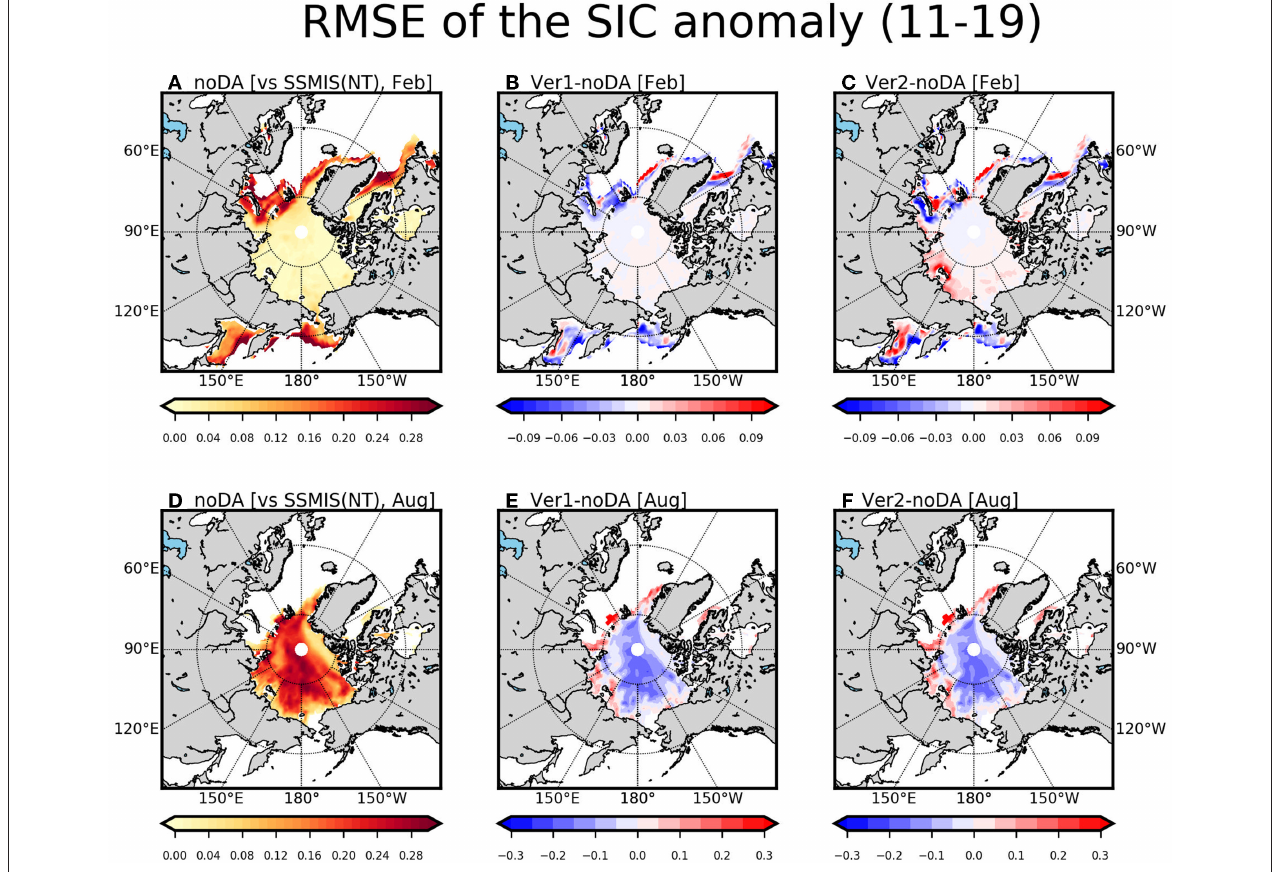
FIGURE 11 | The root-mean-square-errors of sea ice concentration (a fraction from 0 to 1) for noDA, Ver1, and Ver2 with respect to the SSMIS NT observation are calculated in February (A–C) and in August (D–F) . The RMSE of noDA (A,D) and the difference of Ver1 (B,E) and Ver2 (C,F) with respect to noDA are calculated during